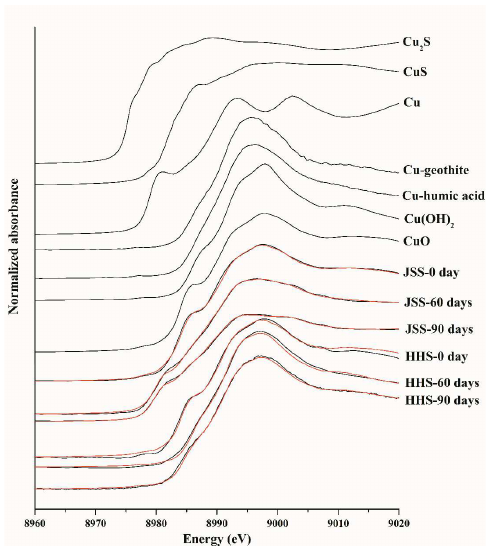
Figure 3. Comparison of Cu K-edge XANES spectra of reference compounds and different soil samples exposed to 1000 mg/kg CuO NPs. Red lines are the linear fitting results.